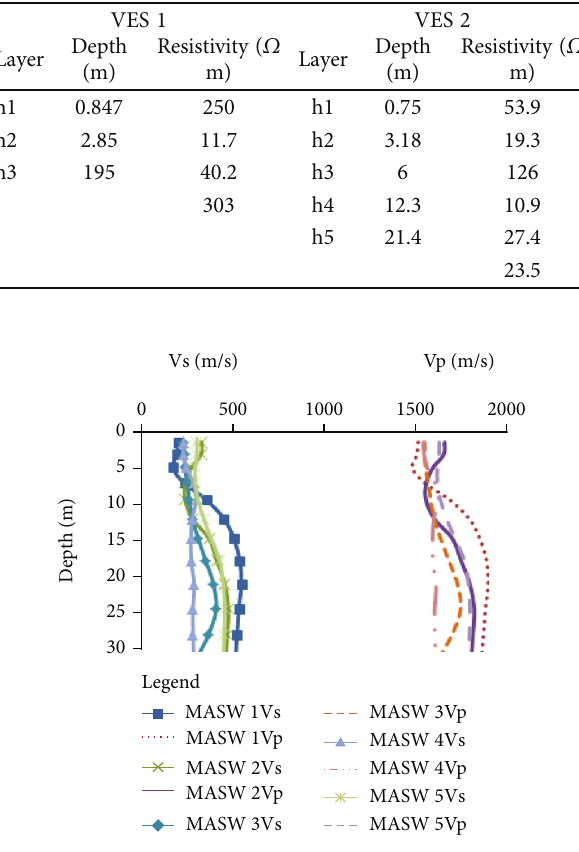
Figure 6: Vs and Vp plots for typical sites in the study